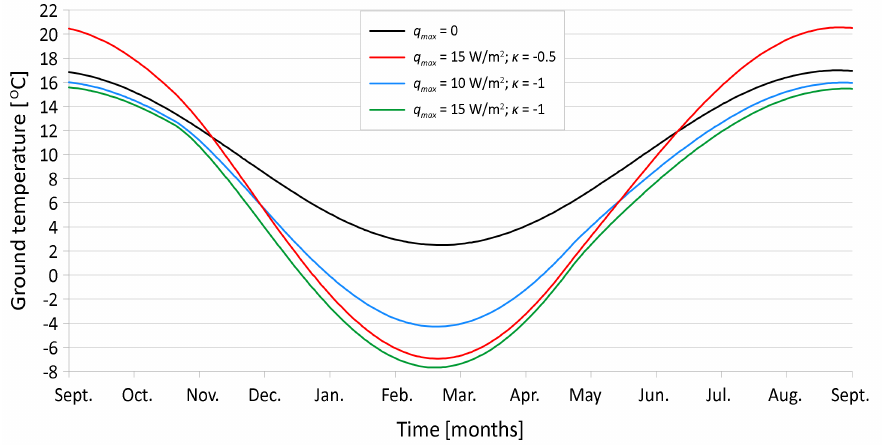
Figure 5. Temporary changes in ground temperature at the depth of heat exchanger’s installation for various conditions of heat extraction from the ground; k = 1.4 W/ ( mK )